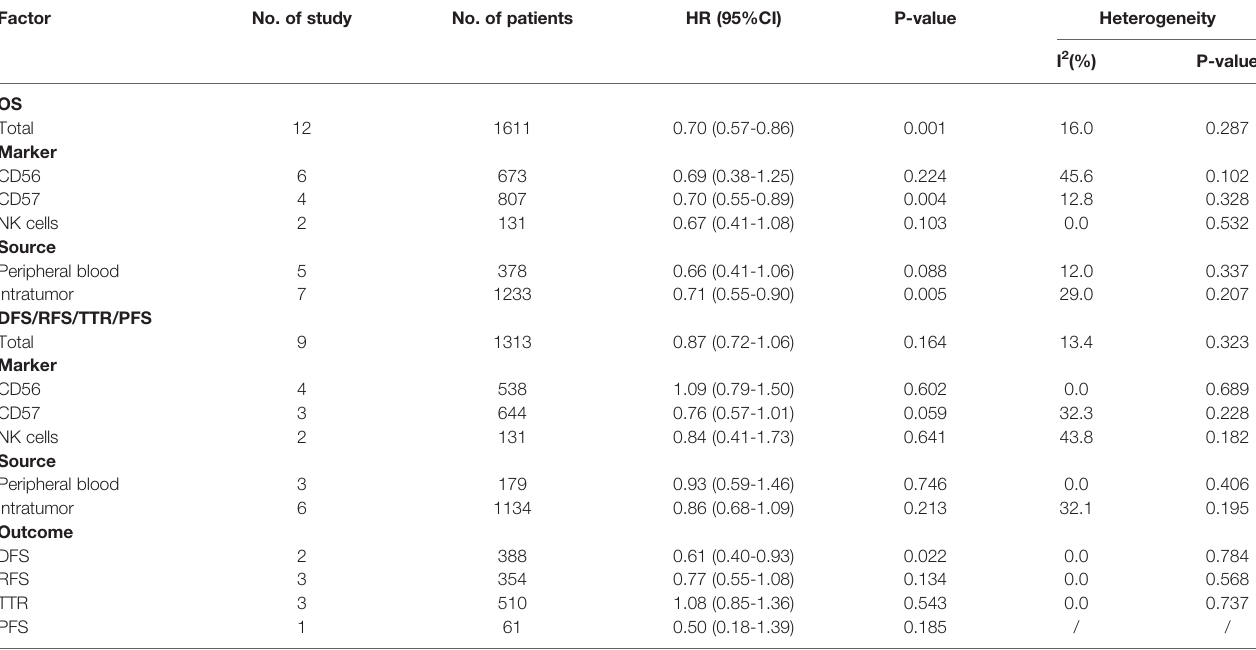
TABLE 2 | Subgroup meta-analysis of the prognostic role of NK cells in HCC.